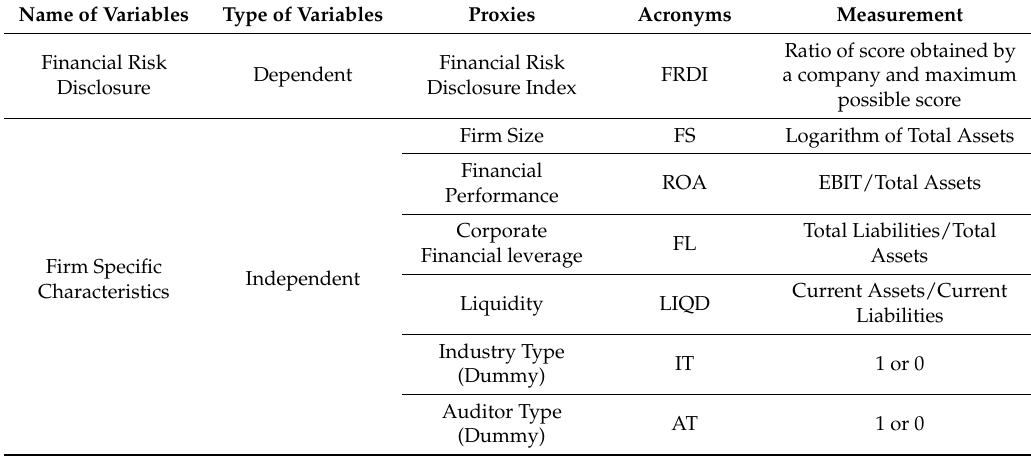
Table 2. List of variables and their measurement methods. FRDI—financial risk disclosure index; FS—firm size; ROA—return on assets; FL—financial leverage; LIQD—liquidity; IT—industry type; AT—auditor type. Name of